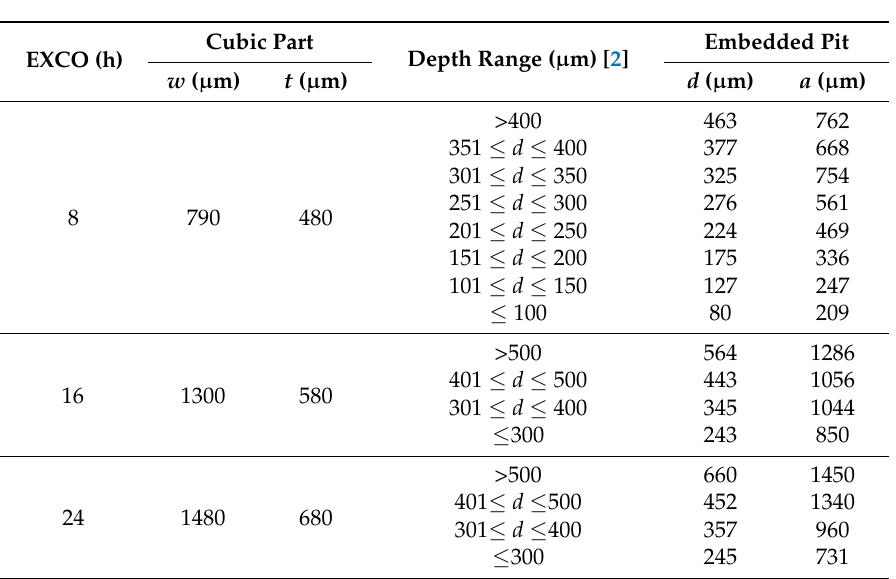
Table 4. RUC dimensions (Side